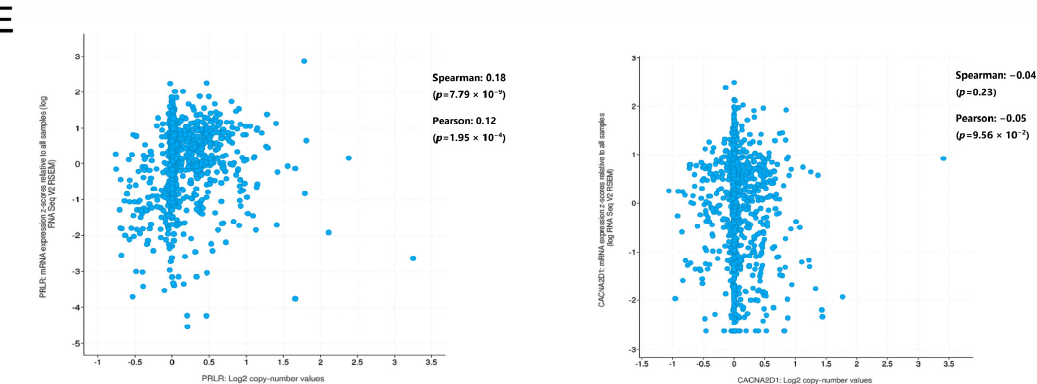
Figure 7. ( A ) Expression of PRLR and CACNA2D1 in BC tissue and normal tissue by using UALCAN. ( B ) The overall survival of PRLR and CACNA2D1 in BC by using GEPIA2. ( C ) The distribution of PRLR and CACNA2D1 genomic alterations in TCGA BRCA shown on a cBioPortal OncoPrint plot. ( D , E ) The association between PRLR and CACNA2D1 copy number and mRNA expression displayed in a dot plot ( D ) and correlation plot ( E ) generated by cBioPortal. Table 4. Expression of PRLR and CACNA2D1 in BC tissue and normal tissue. Data